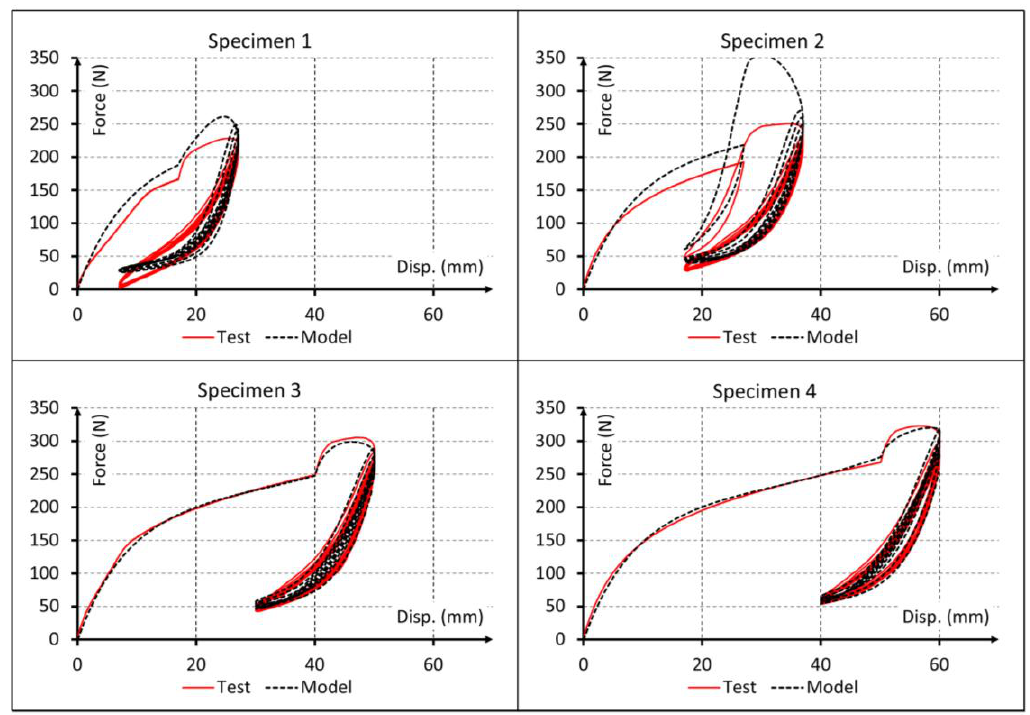
Figure 8. Comparison for all cycles between experimental data and force-displacement curves simulated using the proposed model.